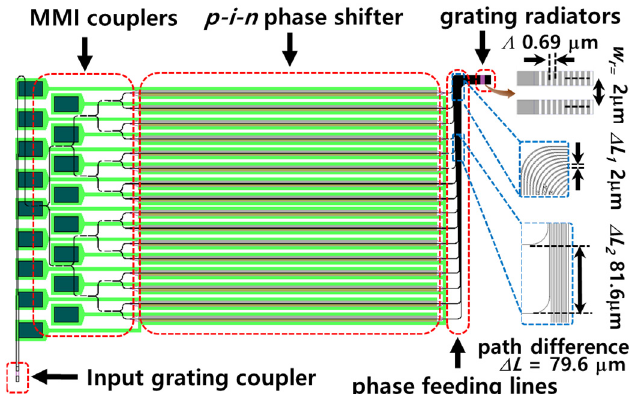
Figure 1. Layout of designed 1 × 16 optical phased array, providing a path difference in the phase- feeding lines.